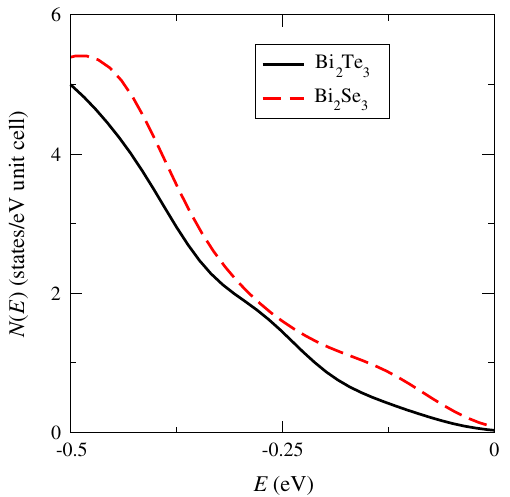
FIG. 2. The calculated density-of-states for the valence bands of Bi 2 Se 3 and Bi 2 Te 3 . Note the larger values for Bi 2 Se 3 just